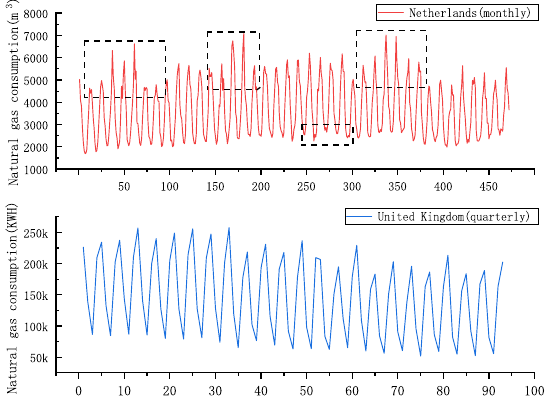
Figure 22. Raw data trend